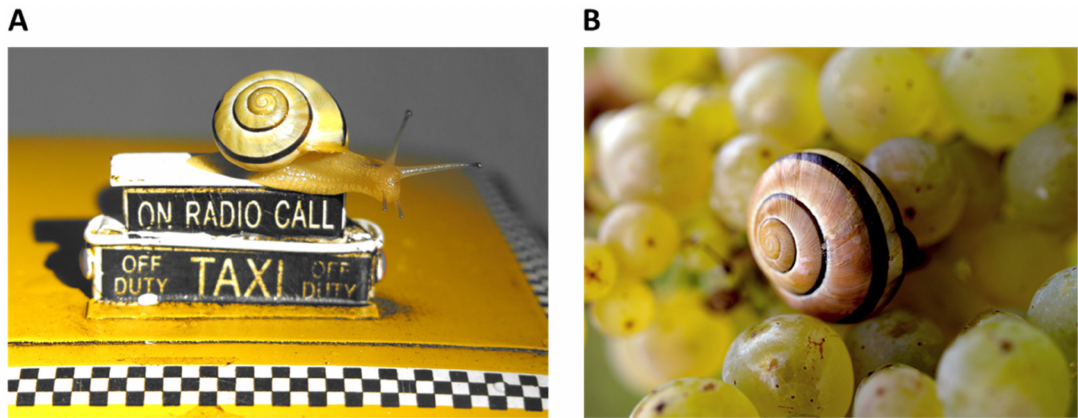
Figure 1. Cepaea snails promoting yeast dispersal in the environment. ( A ). A specimen of Cepaea on a cab. ( B ) A Cepaea snail found in the vineyard on ripe